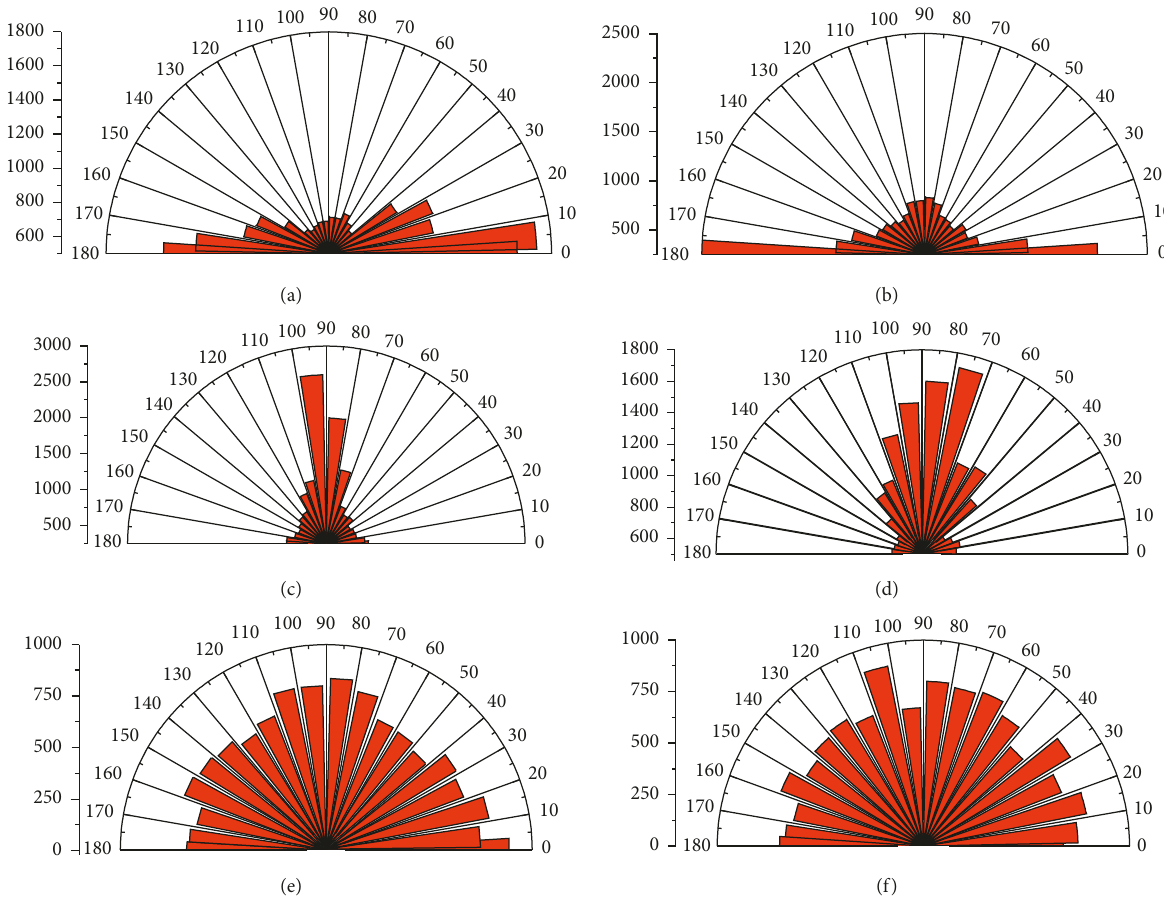
Figure 28: Contact normal orientation evolution before and after loading. (a) H-type particles before loading. (b) H-type particles after loading. (c) V-type particles before loading. (d) V-type particles after loading. (e) R-type particles before loading. (f) R-type particles after